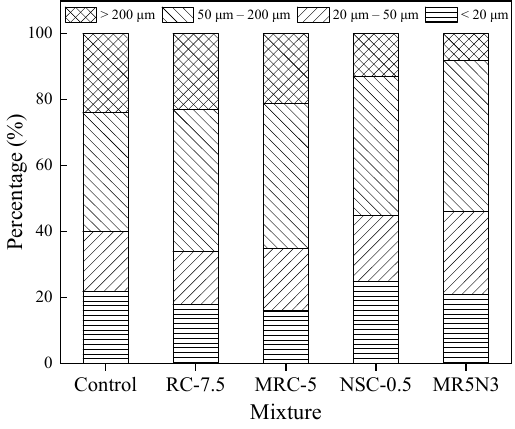
Figure 6. Percentages of pore types.